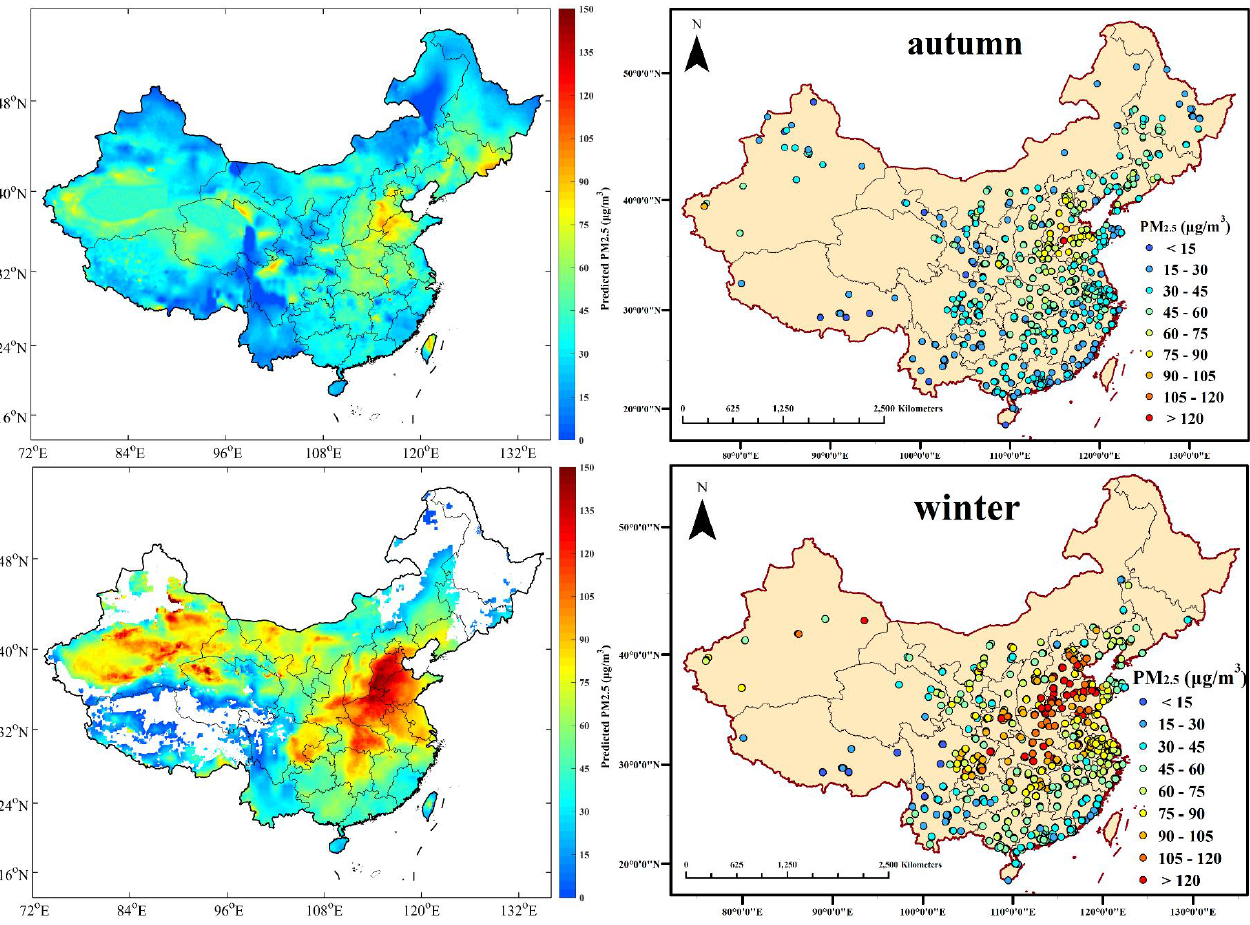
Figure 4. Comparison of seasonal average AOD-derived PM 2.5 and ground-measured PM 2.5 concentrations from real-time datasets, when the corresponding AOD values are available.